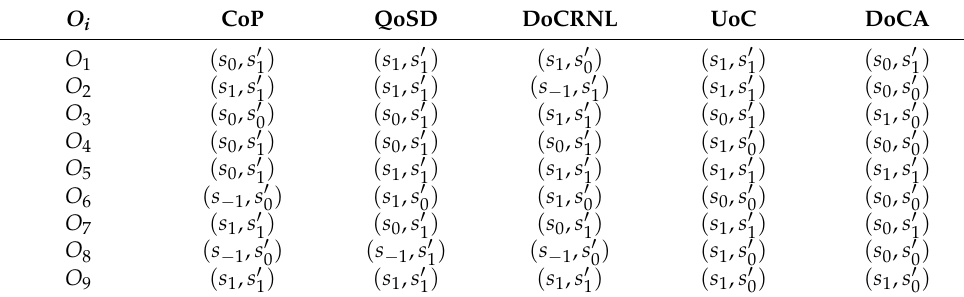
Table 8. Qualitative matrix for criteria evaluation by decision-maker 4 ( Γ 4 ).